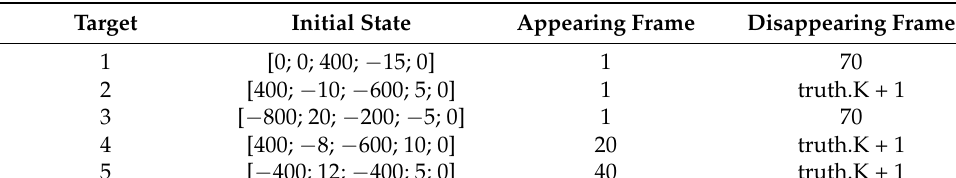
Table 2. Initial state of linear Gaussian measurement model target.